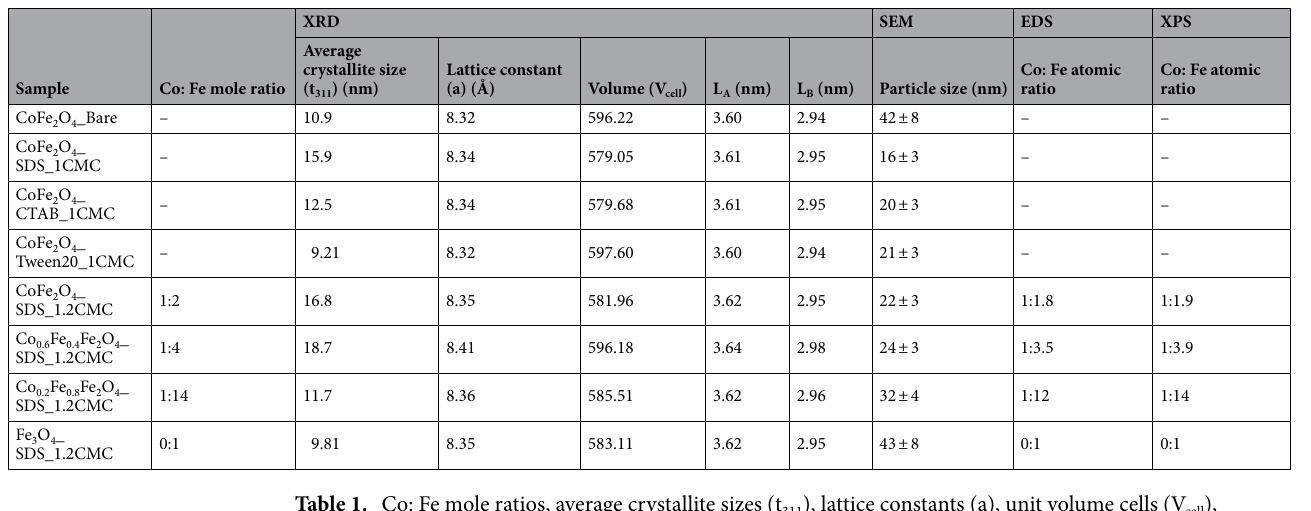
Table 1. Co: Fe mole ratios, average crystallite sizes (t 311 ), lattice constants (a), unit volume cells (V cell ), hopping lengths for tetrahedral site (L A ), hopping lengths for octahedral site (L B ), particle sizes, and the Co: Fe atomic ratios from EDS and XPS of cobalt ferrite